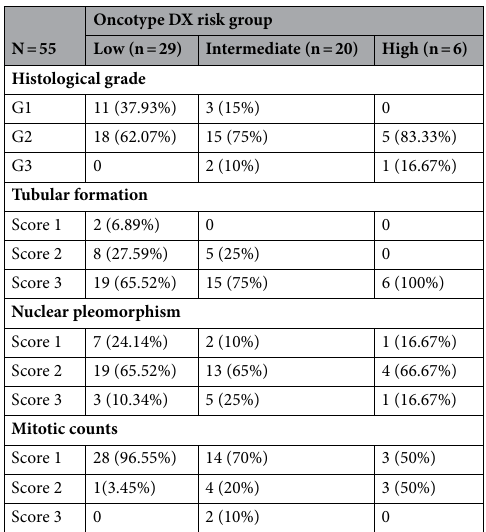
Table 2. Frequencies of clinicopathological parameters for Oncotype DX risk group’s categories.